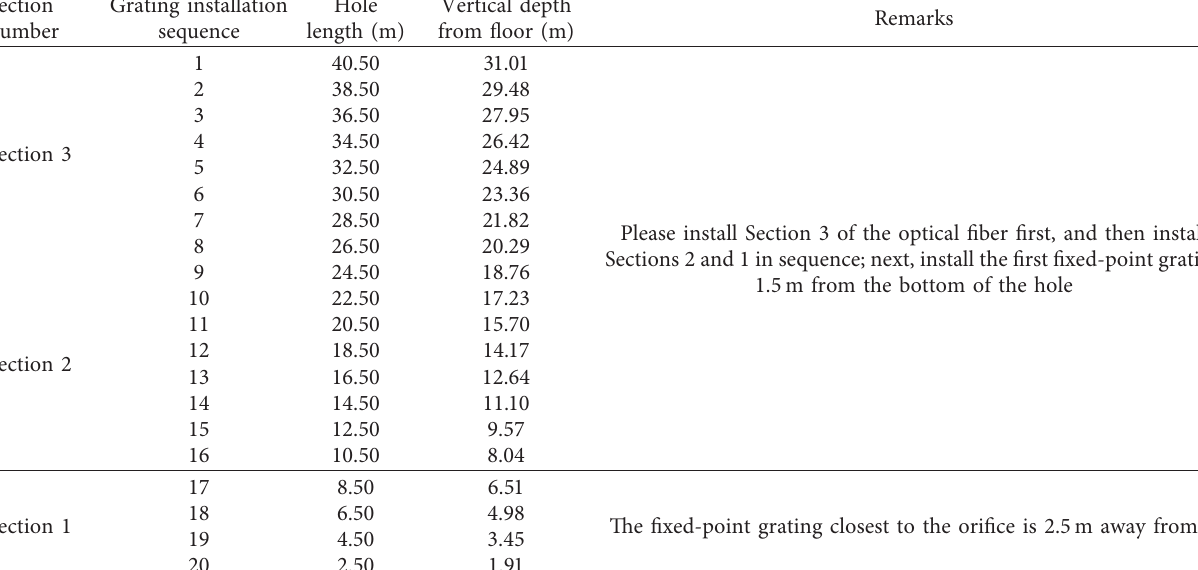
Table 1: Installation parameters of fixed-point fiber grating